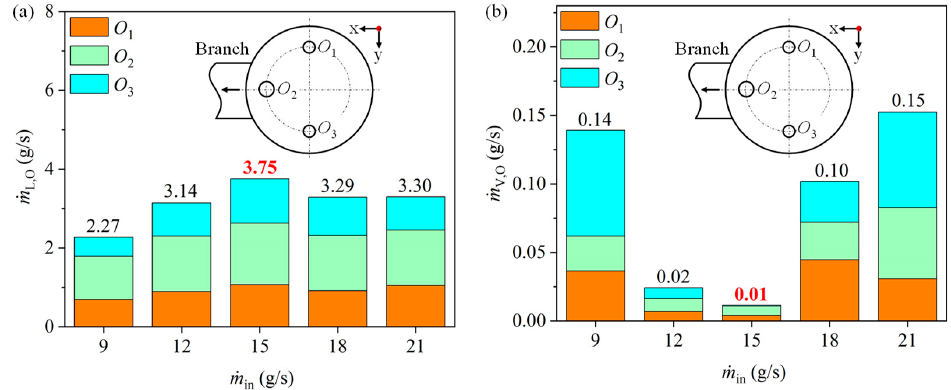
Figure 5. Mass flow rate of ( a ) liquid; ( b ) vapor at each orifice.